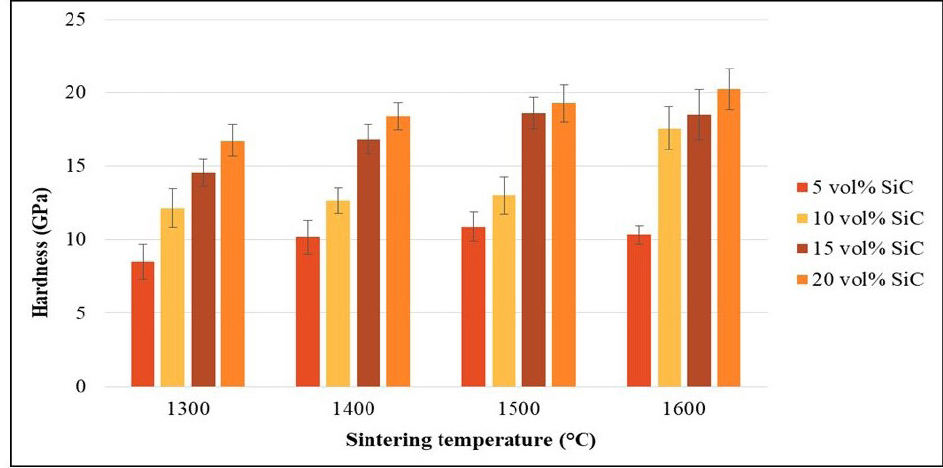
Figure 8: Hardness of Al